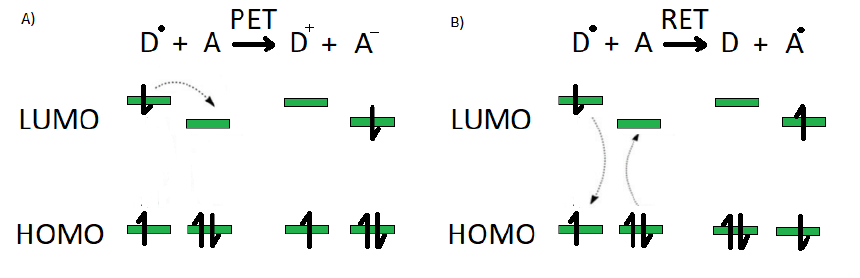
Figure 1. Comparison of PET ( A ) and RET ( B ) mechanisms in the detection of